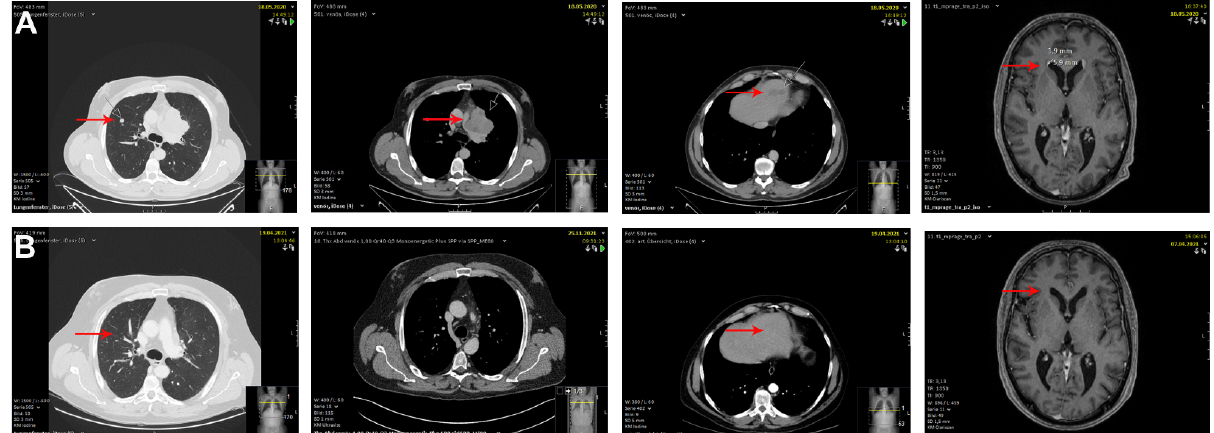
Figure 5. Results from MRI and CT scans of the 53-year-old male patient prior to the administration of combined checkpoint blockade in May 2020 and results from the latest scans from July 2021. Compared to initial staging results showing melanoma pulmonary, cardiac, hepatic and cerebral metastasis ( A ), the staging results from July 2021 show a complete remission of all previously reported metastasis with no evidence of disease at this stage of follow up ( B ).